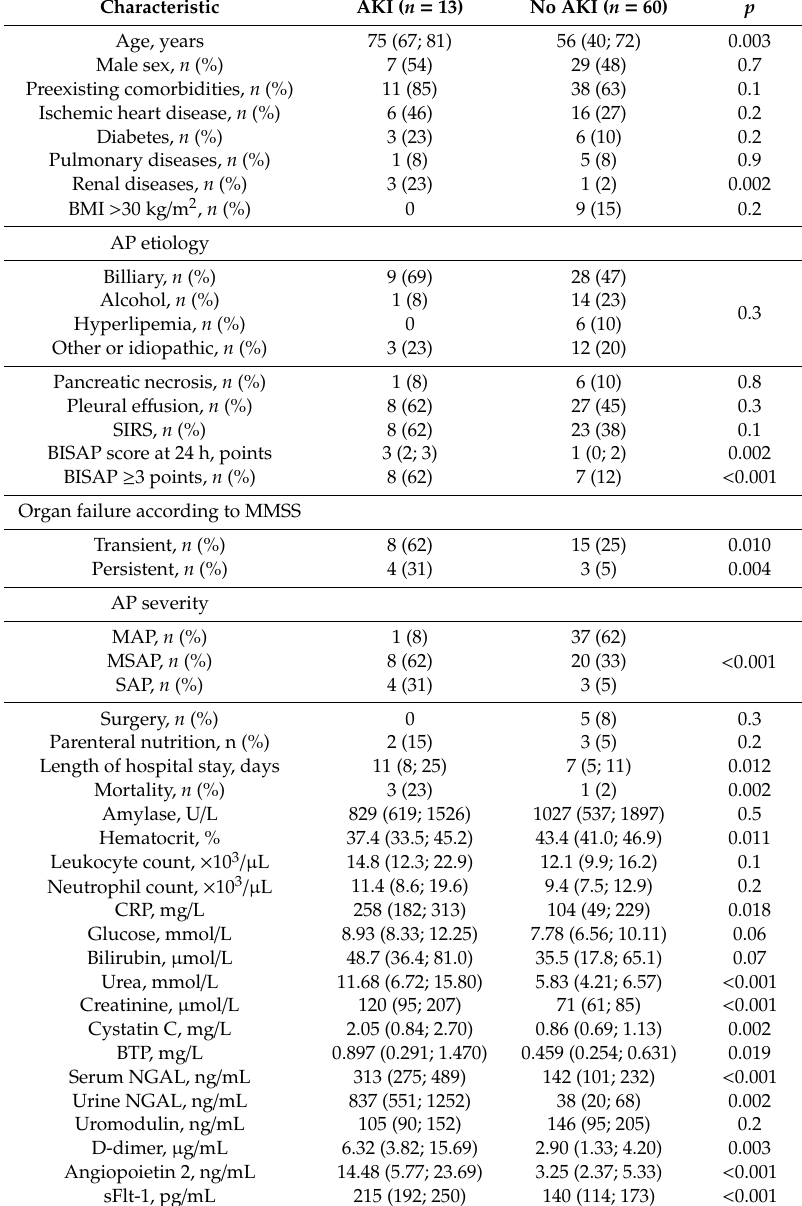
Table 1. Clinical characteristics of patients with acute pancreatitis (AP) and the maximum laboratory results obtained on first two days (48 h) of hospital stay (or minimum result in case of uromodulin). The quantitative data were presented as median (lower; upper